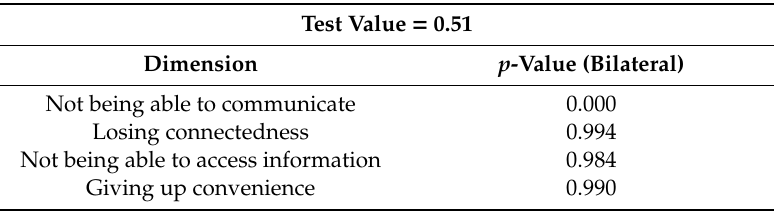
Table 6. Proportionality test.